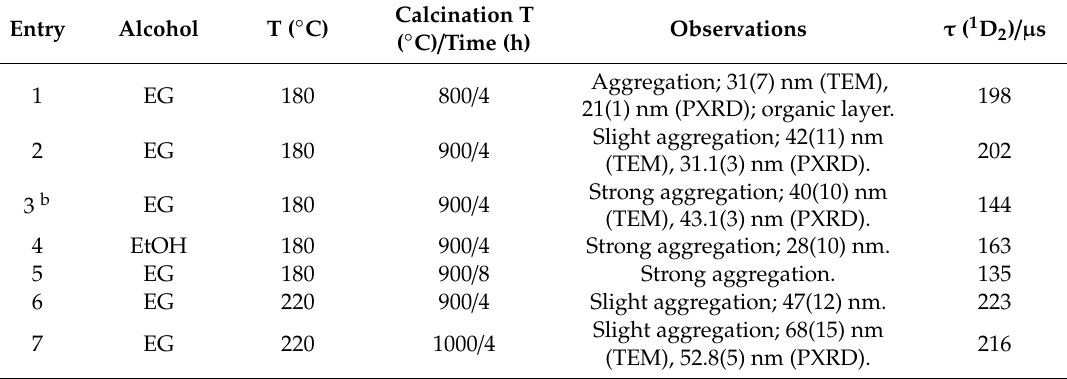
Table 6. Luminescence lifetime of the Pr 3 + 1 D 2 → 3 H 4 emission transition at RT for Y 2 O 3 : Pr 3 + NCs synthetized by solvothermal method a